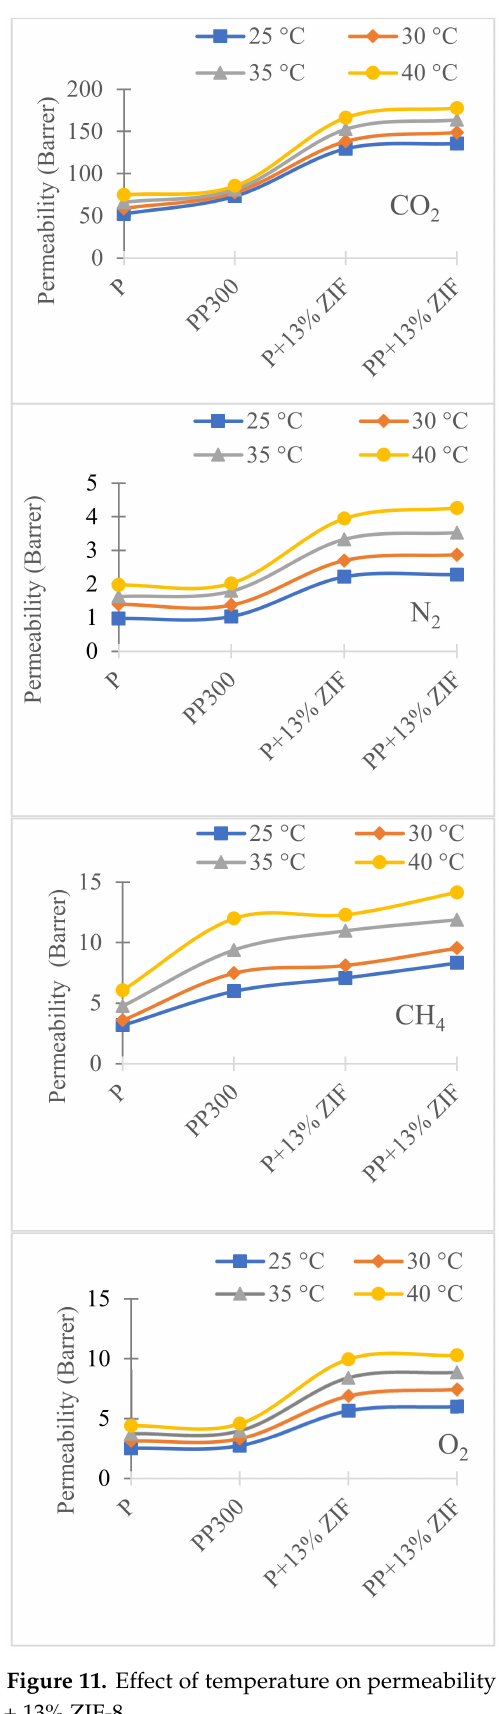
Figure 11. Effect of temperature on permeability for neat Pebax (P), PP300, P + 13% ZIF-8 and PP + 13%